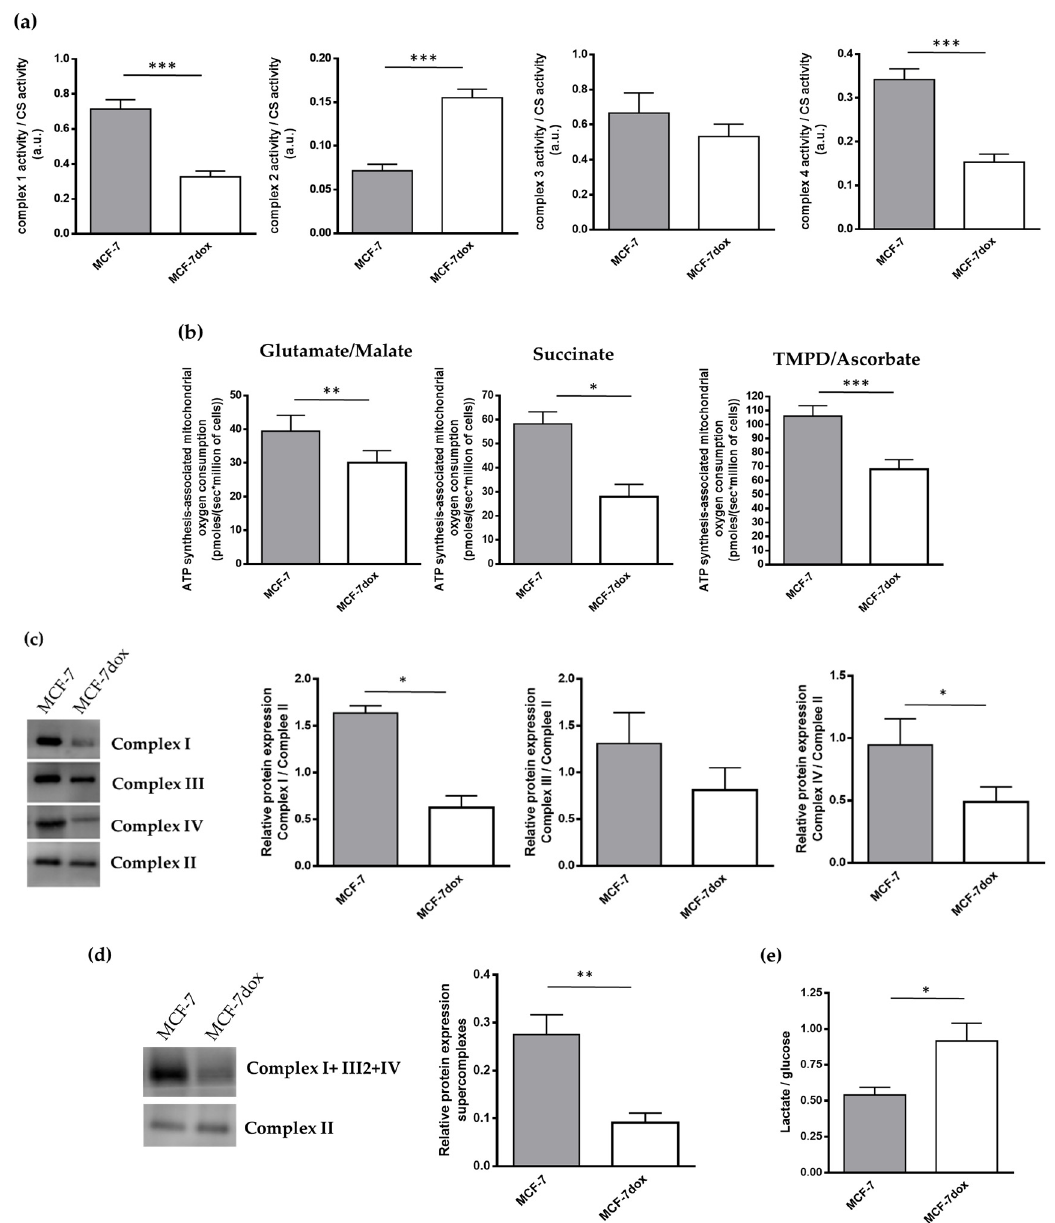
Figure 1. Increased glycolysis and dysfunctional mitochondria in DOX-resistant breast cancer cells. ( a ) Enzymatic activities of respiratory chain complexes 1, 2, 3, or 4 and citrate synthase were measured by spectrophotometry. Results are presented as the ratio of respiratory chain complexes activity to citrate synthase activity ( n = 6); ( b ) mitochondrial oxygen consumption was measured by high-resolution respirometry. Experiment was carried out in the presence of glutamate + malate (complex I, n = 5), succinate (complex II, n = 6), or TMPD + ascorbate (complex IV, n = 9) and ADP as substrates; ( c ) holoenzyme for mitochondrial complex 1, 2, 3, and 4 was analyzed by BN Page. Results are presented as the ratios of complex 1, 3, or 4 holoenzyme content to complex 2 holoenzyme content ( n = 6); ( d ) respiratory chain supercomplexes assembly was determined by Blue Native Page. Results were expressed as a ratio to complex II amount. ( e ) The levels of lactate production and glucose consumption were measured by spectrophotometry. Results are presented as the ratio of lactate production to glucose consumption ( n = 21). The data are presented as mean ± SEM. * p < 0.05, ** p < 0.01, *** p <